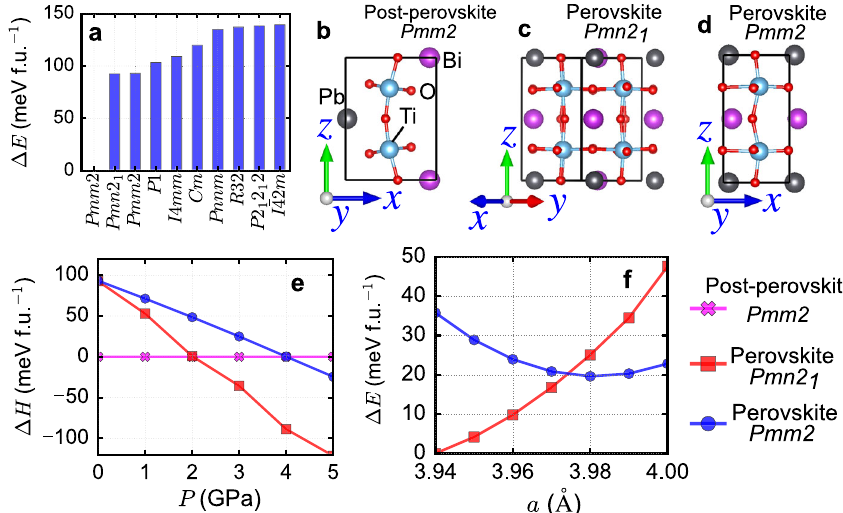
Fig. 1 The lowest-energy crystal structures and phase transitions. a Ten lowest-energy crystal structures of BPTO predicted by CALYPSO and DFT calculations. b Post-perovskite Pmm 2 structure; c Perovskite Pmn 2 1 structure; d Perovskite Pmm 2 structure. e Enthalpy of the three lowest-energy structures as a function of pressure. The enthalpy of the post-perovskite Pmm 2 structure under each pressure is set as the zero point. f Total energy of the two lowest-energy perovskite structures as a function of epitaxial strain. The energy of the perovskite Pmn 2 1 structure constrained by an in-plane lattice constant of 3.94 Å is chosen as the zero